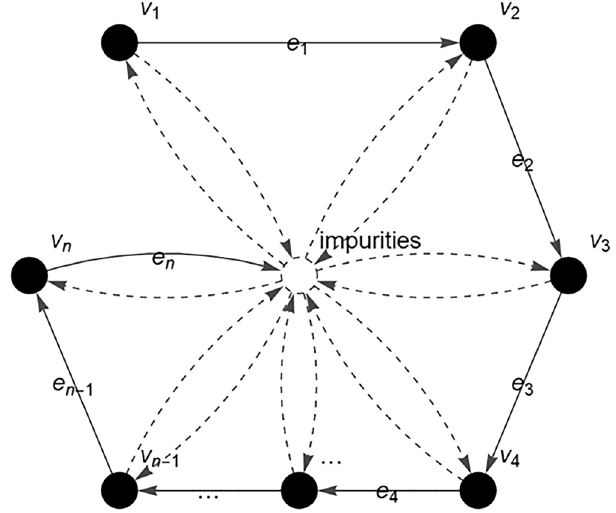
Figure 6. Fuzzy autocatalytic set (FACS) graph of FTIR banknote’s spectra.